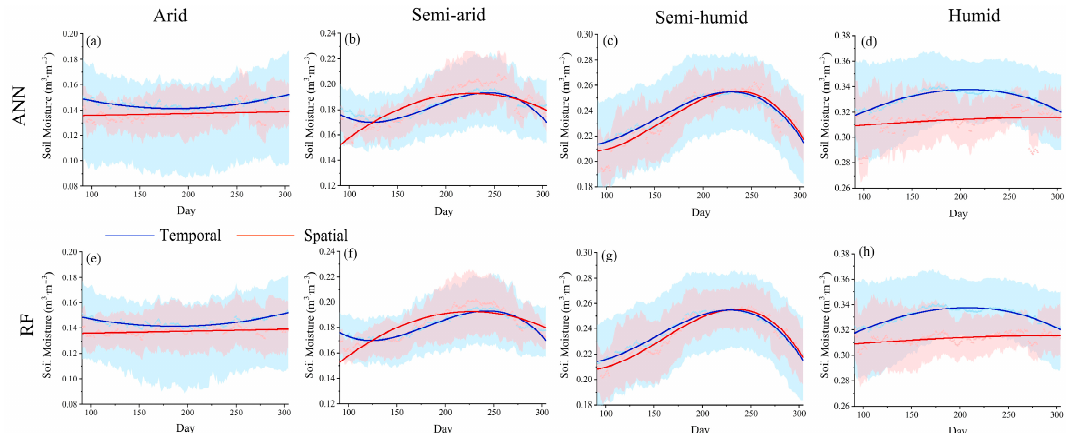
Figure 6. Distribution of reconstructed daily soil moisture in the temporal and spatial domains with the ANN ( a – d ) and RF ( e – h ) models in four climate zones during 1979 − 2019. The blue and red solid lines are the mean values in each day. The blue and red shades represent the 5% and 95% percentiles of soil moisture in each climate zone.